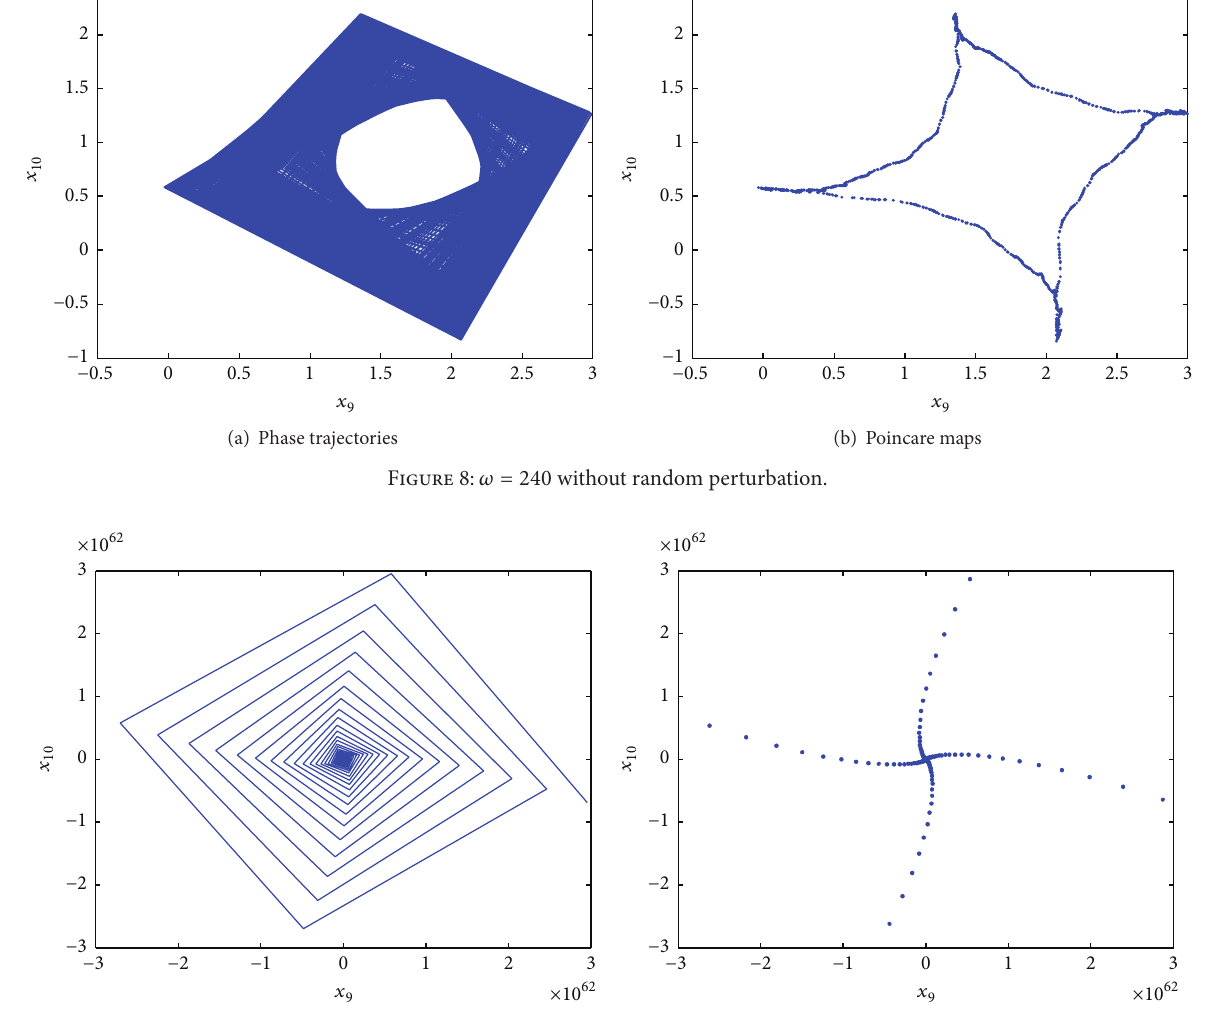
Figure 7: 𝜔 = 200 without random perturbation.